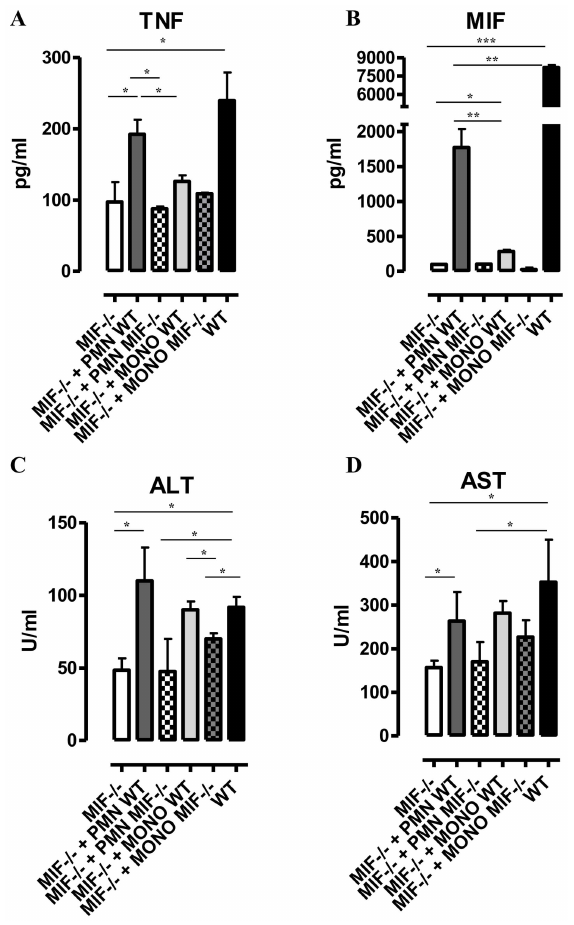
Figure 5. Neutrophil-derived MIF and monocyte-derived MIF contribute to different extent to TNF production and liver injury in T.brucei infected mice. TNF and MIF levels from liver cell cultures (A, B), serum ALT (C) and AST (D) levels of infected (day 24 p.i.) Mif 2 / 2 mice (white box), of infected Mif 2 / 2 mice treated with neutrophils from WT (dark grey box) or Mif 2 / 2 (white hatched box) infected mice, of infected Mif 2 / 2 mice treated with monocytes from WT (light grey box) or Mif 2 / 2 (darker grey hatched box) infected mice and of infected WT mice (black box). Results are representative of 3–4 independent experiments and presented as mean of 3 individual mice 6 SEM (*: p-values # 0.05, **: p-values # 0.01, ***: p-value # 0.001).